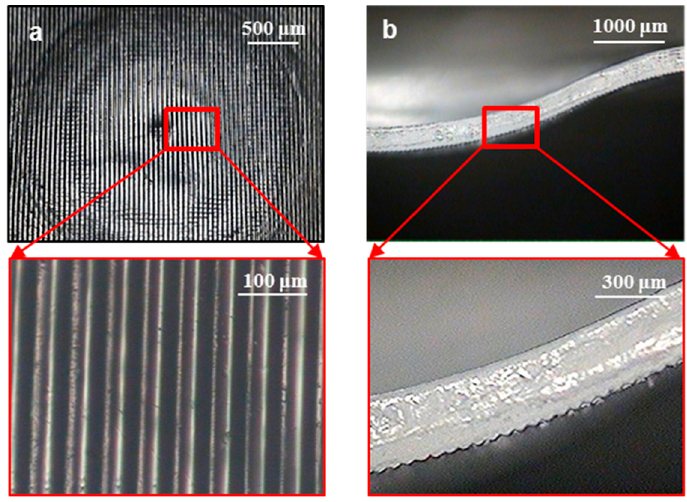
Figure 8. Microscopic images of the prism micropatterns on a curved surface: ( a ) bottom view; ( b ) sectional view.